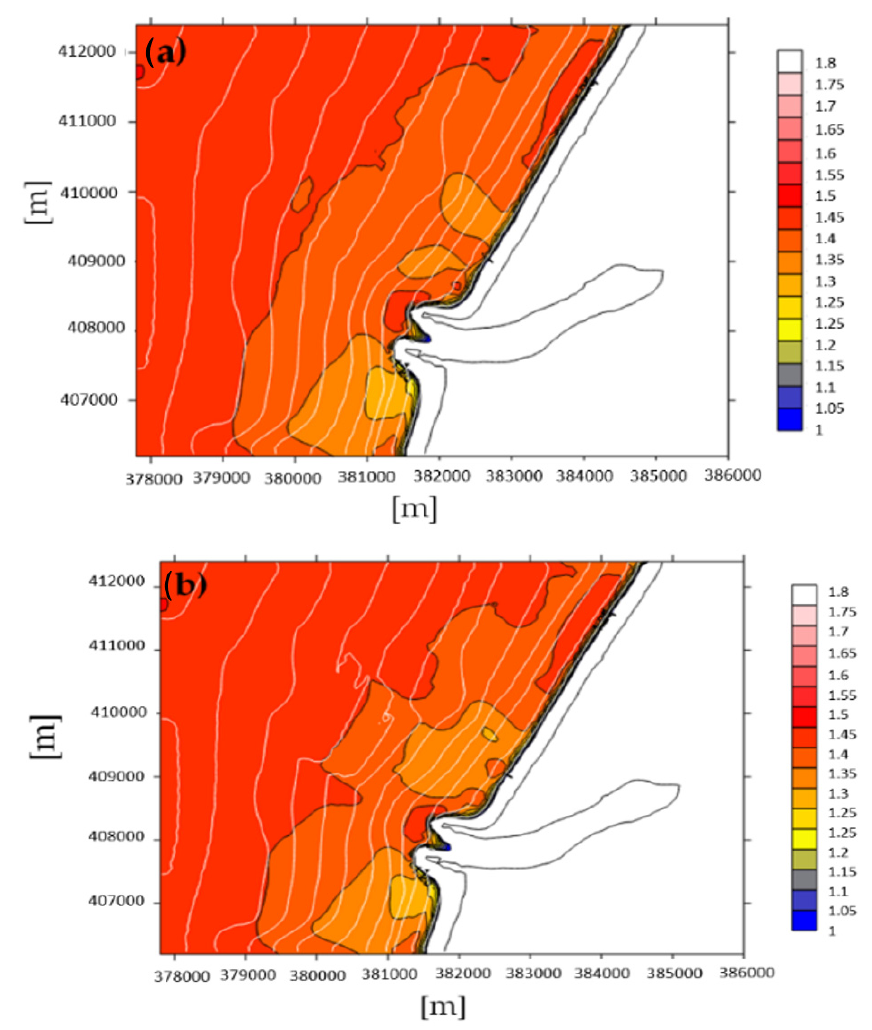
Figure 6. Map of local significant wave height distribution for ( H s 0 = 1.5 m, T p = 8 s), ( a ) before dredging (with current bathymetry), ( b ) after dredging of 2 m depth. The legend indicates the values of H s in meters.